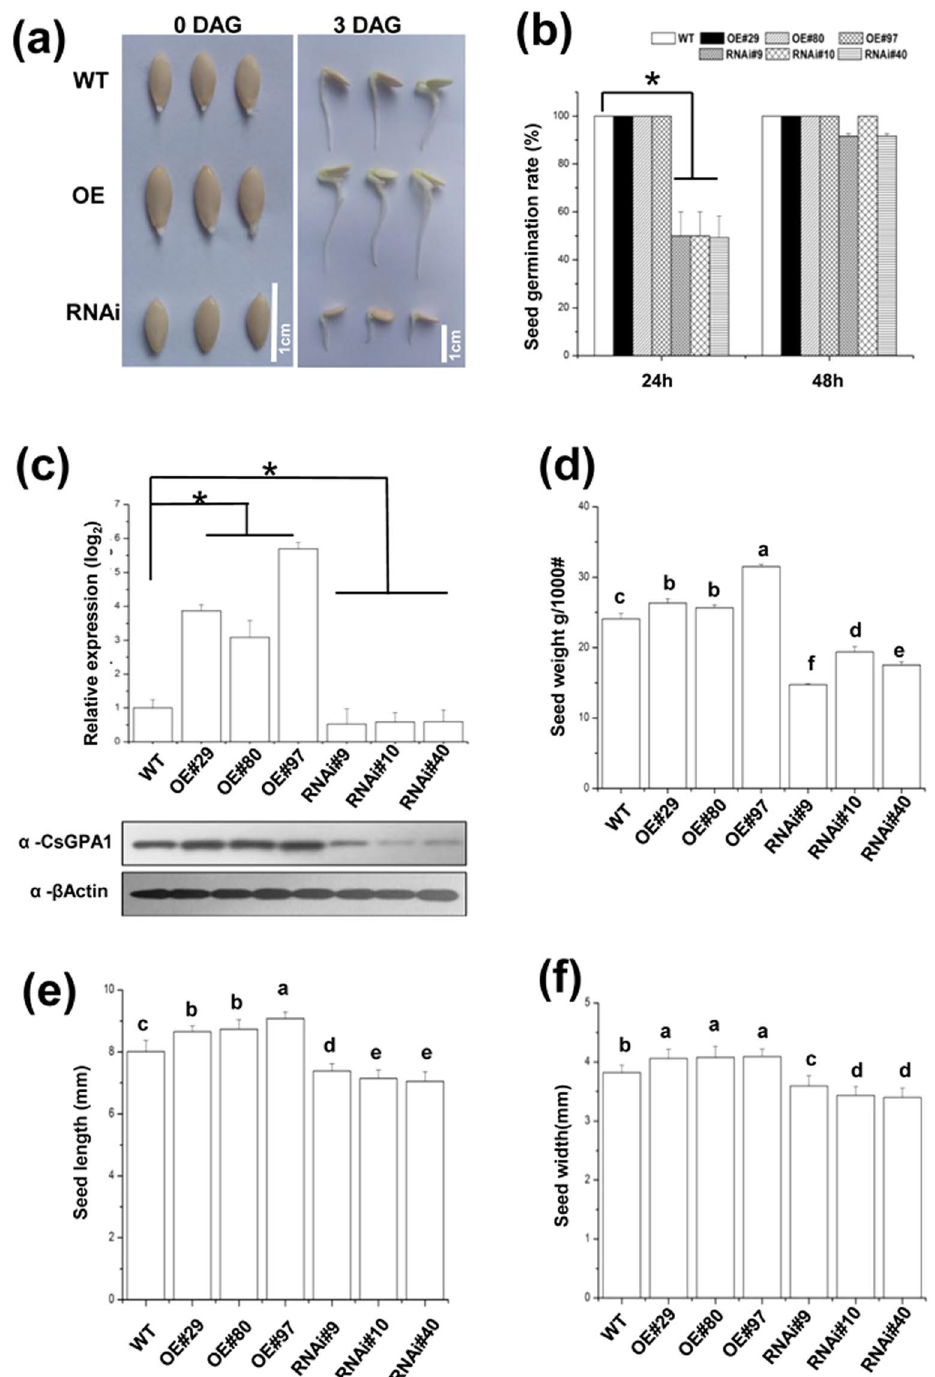
Figure 5. Seed germination in transgenic cucumber lines. ( a ) Images of germinated seeds 0 and 3 d after germination from transgenic cucumber lines. Scale = 1 cm. ( b ) Seed germination rate of transgenic cucumber lines after 24 h and 48 h of darkness. ( c ) Relative CsGPA1 expression and western blot with anti-CsGPA1 monoclonal antibody at 6 days after germination in different transgenic cucumber lines. ( d ) Weight (g) per thousand seeds of different transgenic cucumber lines. ( e ) Seed length of transgenic cucumber lines. ( f ) Seed width of transgenic cucumber lines. Seeds were considered to have germinated if the emerging radicle grew to 3 mm. Seed germination rates (%) were analyzed at the indicated time points. Data are presented as the mean ± standard deviation of three independent replicates with at least 20 seeds counted per replicate. Values that differed significantly from the WT values are indicated. * p < 0.05 according to a Bonferroni post-hoc test. OE, CsGPA1- overexpressing transgenic plants; RNAi, CsGPA1- silenced transgenic